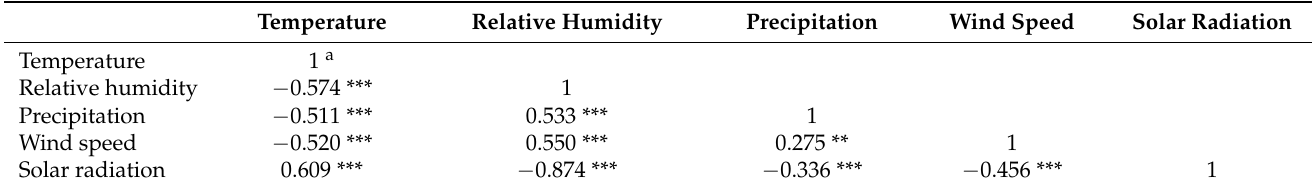
Table 5. Pearson moment correlations ( r ) matrix between five weather variables recorded from November 2018 to May 2019 inclusive in 25 wheat growing governorates of Egypt from which grain samples were collected (one weather station per